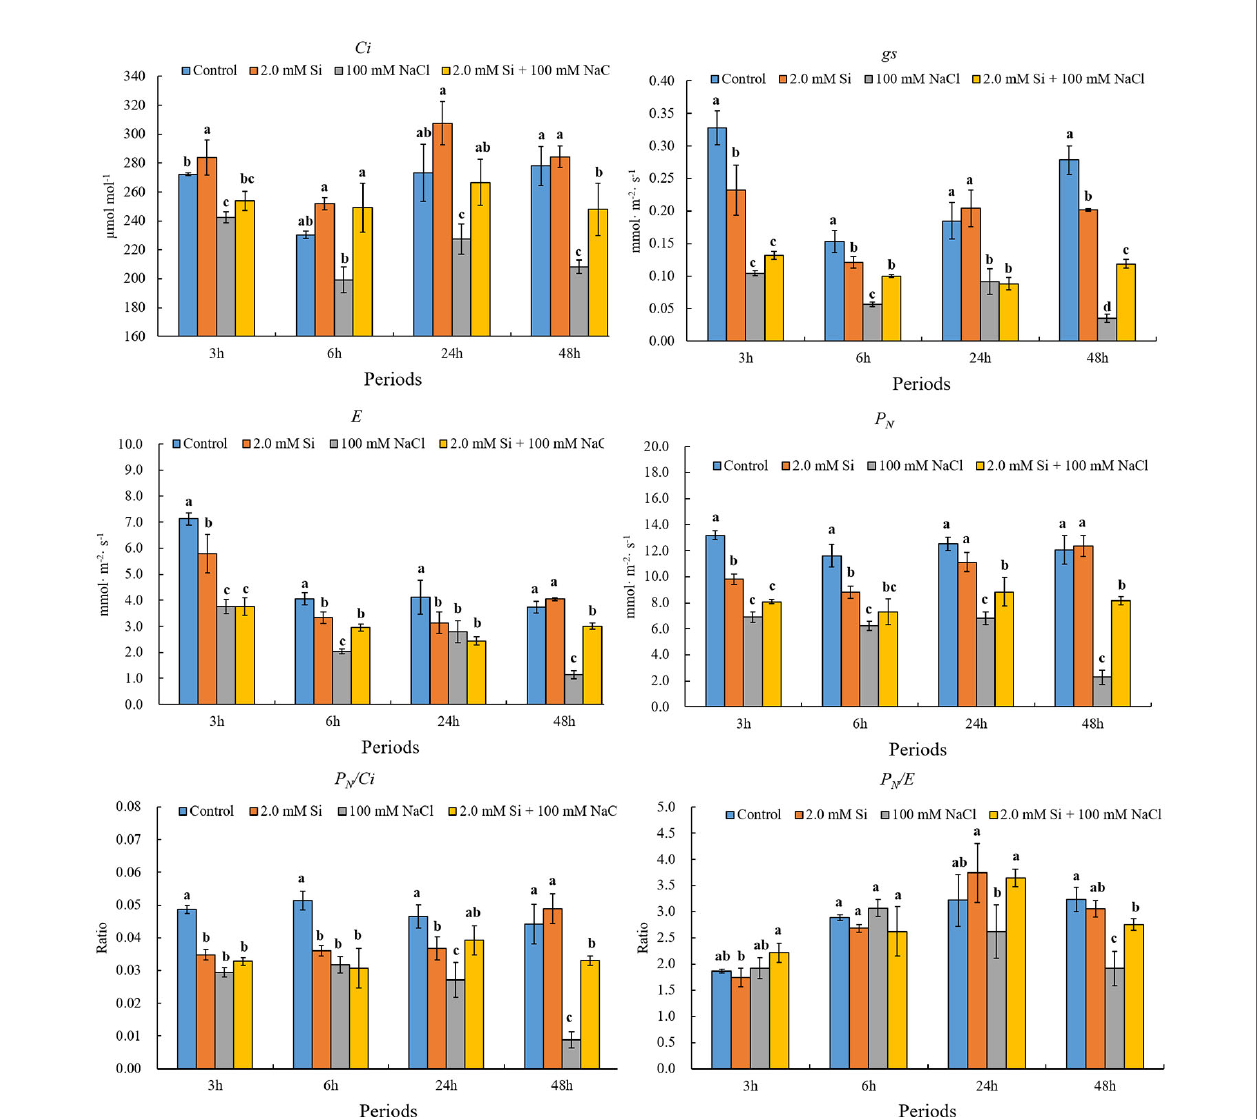
FIGURE 3 | Effect of single or combined Si and NaCl treatment on net photosynthesis ( P N ), transpiration rate ( E ), stomatal conductance ( g s ), intercellular CO 2 concentration ( C i ), P N / C i , and P N / E in soybean plants. Data were collected at 3, 6, 24, and 48 h after stress exposure. Different letters above error bars indicate signi fi cant differences by Duncan's multiple range test ( P < 0.05). Data were collected in triplicate and are presented as the average ± standard error ( n = 10).